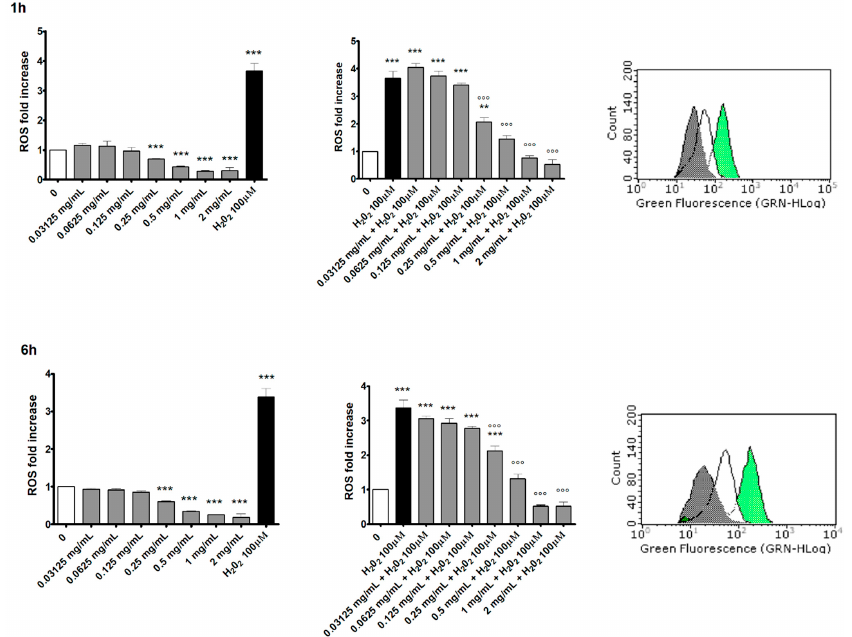
Figure 4. ROS fold increase on TK6 cells after 1 h and 6 h treatment with the SMD and/or positive control (H 2 O 2 ) at the indicated concentrations compared to the concurrent negative control (0 mg/mL). Each bar represents the mean ± SEM of at least three independent experiments. Data were analysed using repeated ANOVA, followed by Dunnet post-test. ** p < 0.01 vs. (0 mg/mL); *** p < 0.001 vs. (0 mg/mL). °°° p < 0.001 vs. (H 2 O 2 100 µM). Representative FCM histograms of SMD 1 mg/mL+ H 2 O 2 (grey), concurrent negative control (white) and H 2 O 2 (green) cultures. *** p < 0.001 vs. (0 mg/mL). ◦◦◦ p < 0.001 vs. (H µ M). Representative FCM histograms of 2 O 2 100 SMD 1 mg/mL + H 2 O 2 (grey), concurrent negative control (white) and H 2 O 2 (green)